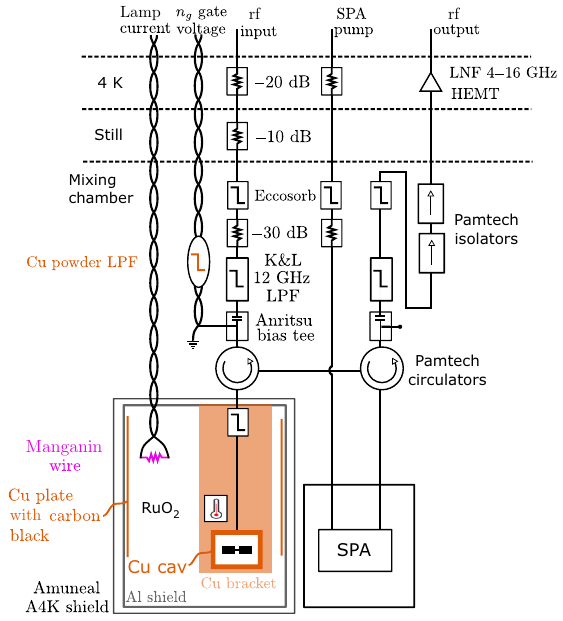
FIG. 11. The cryogenic measurement